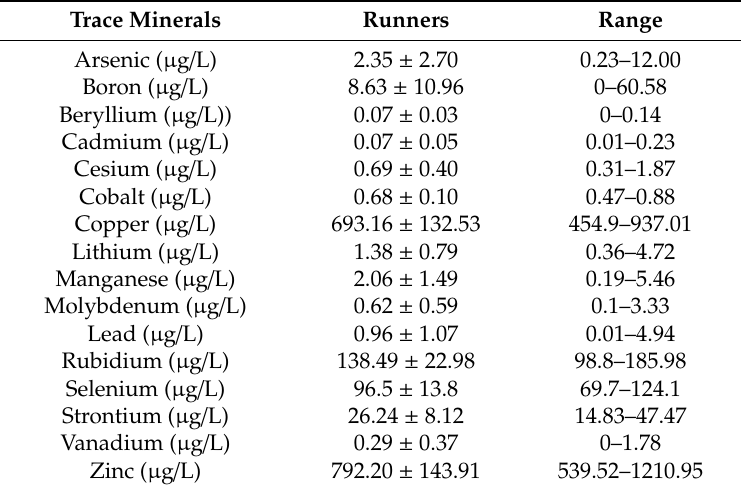
Table 3. Trace mineral concentrations in the runners.